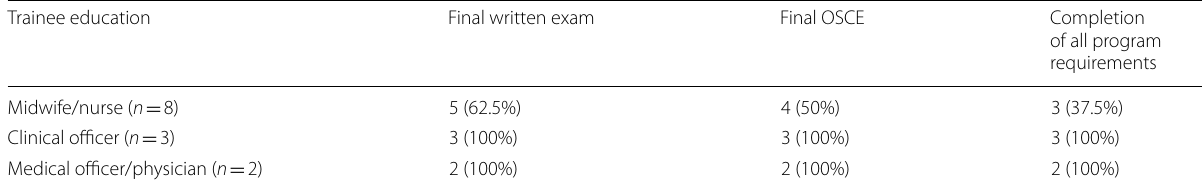
Table 5 Summary of passing scores and completion of program requirements by trainee education